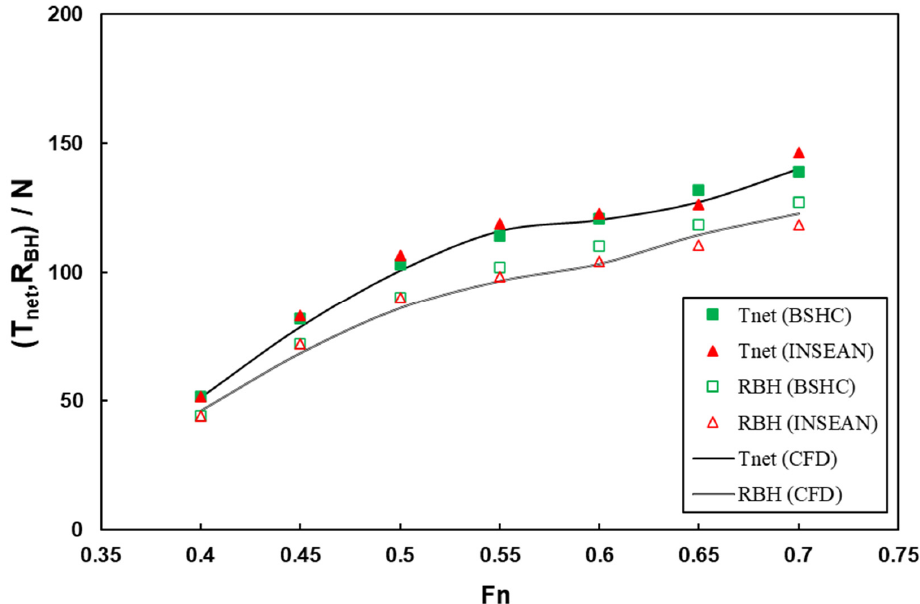
Figure 25. Comparison of the gross thrust and bare hull resistance between EFD and CFD.